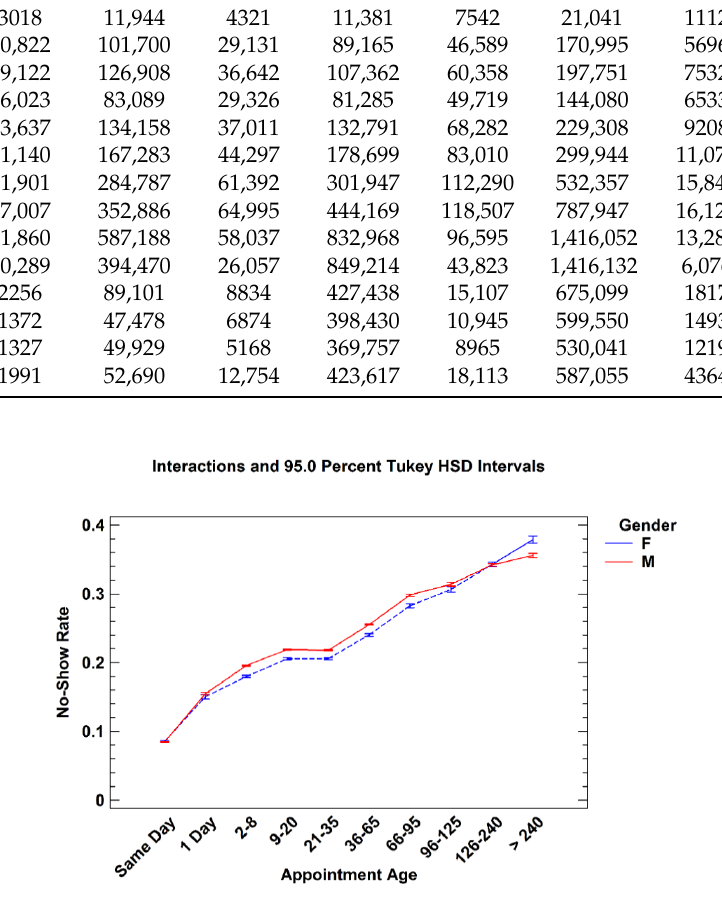
Table 3. Appointment frequencies for all service lines.